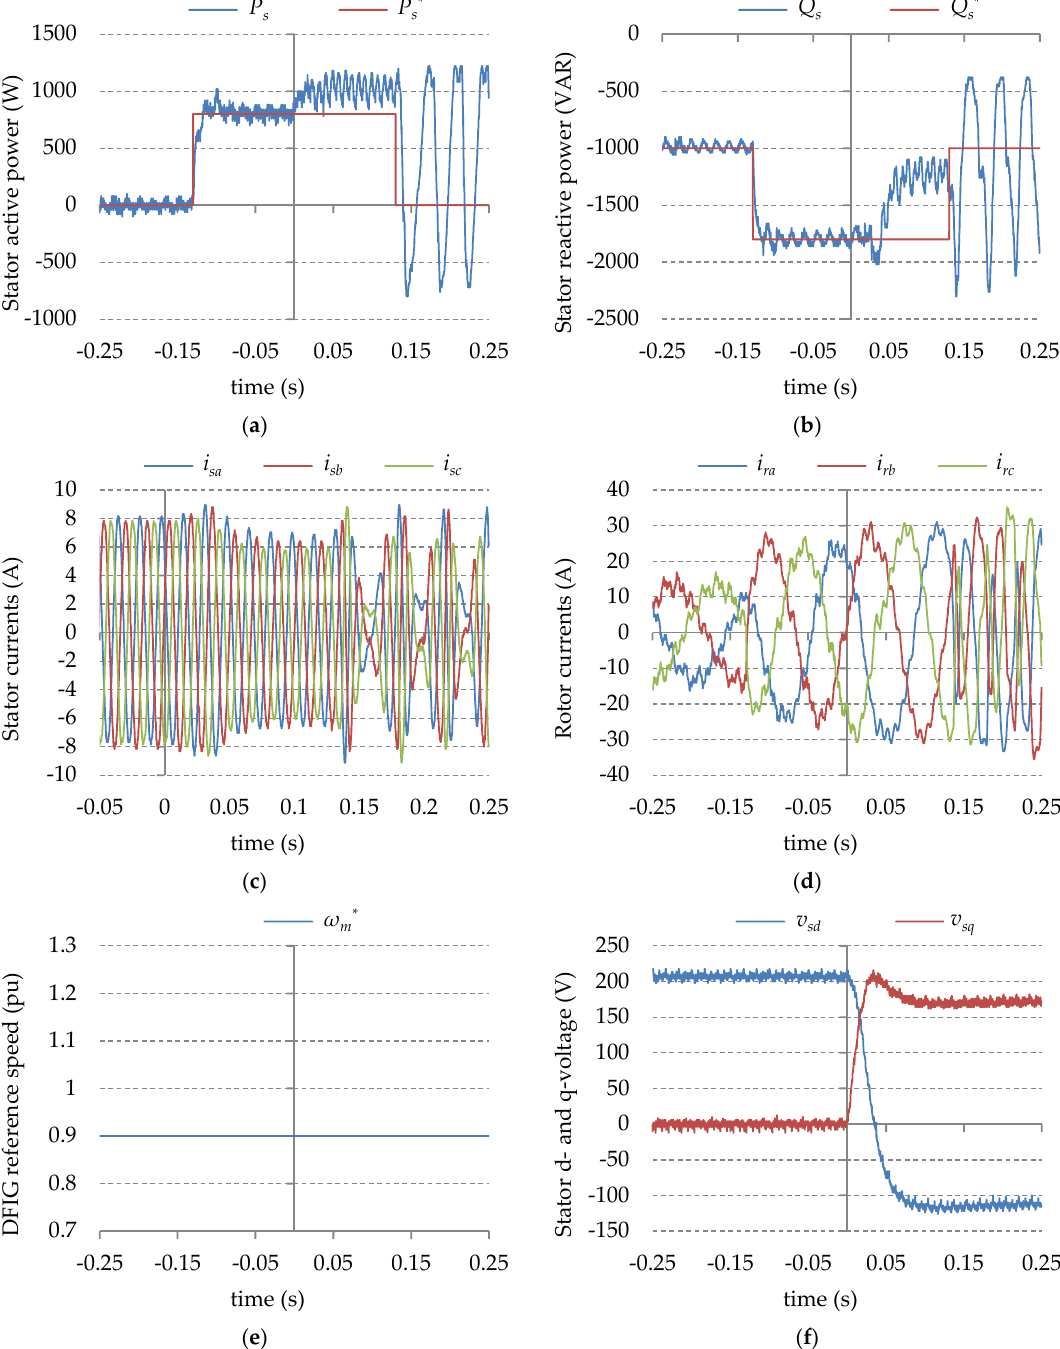
Figure 12. Experimental results for the effect of variation of the stator voltage orientation on the conventional decoupled P ‐ Q control: ( a ) stator active power; ( b ) stator reactive power; ( c ) stator currents; ( d ) rotor currents; ( e ) DFIG’s reference speed; ( f ) stator (grid) d ‐ and q ‐ voltage.